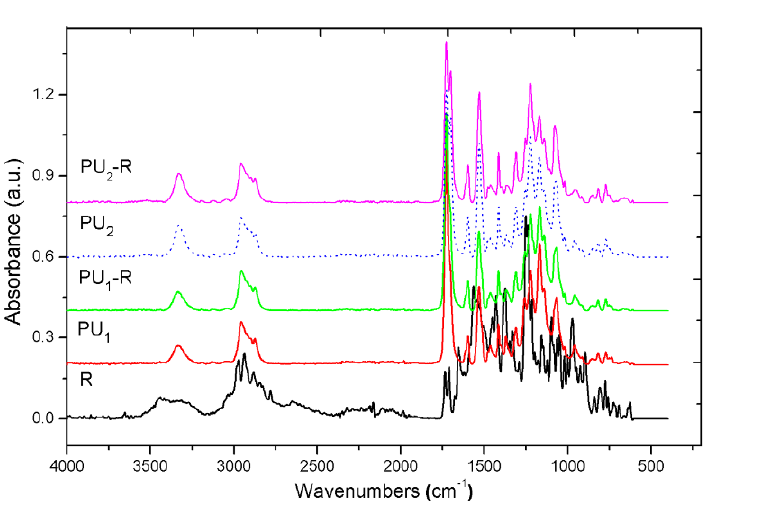
Figure 1. ATR-FTIR of R, PU